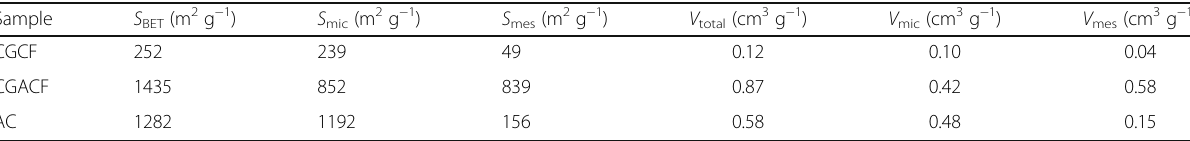
Table 1 Pore parameters of the samples Sample